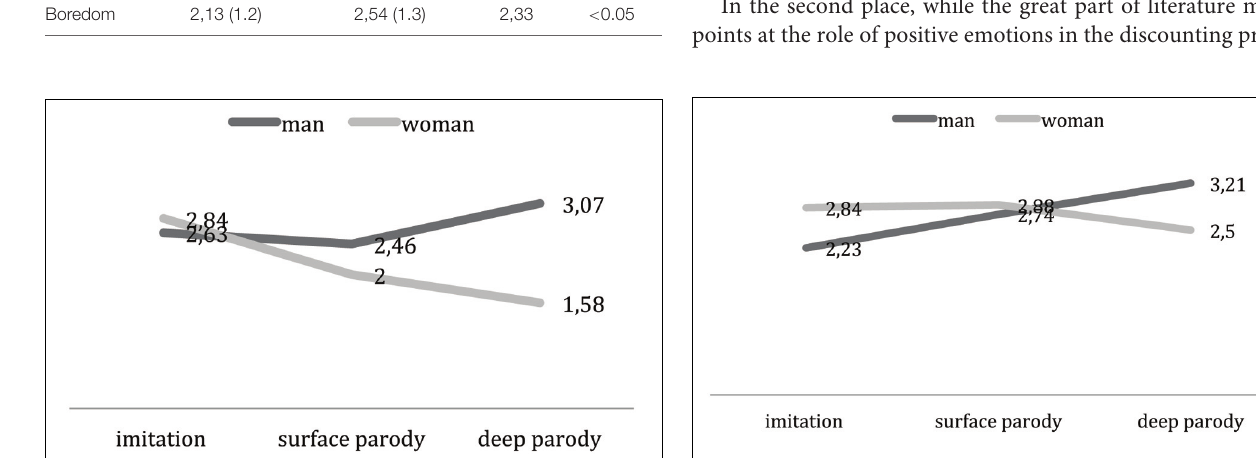
FIGURE 6 | Type of representation ∗ Parodied politician’s gender on